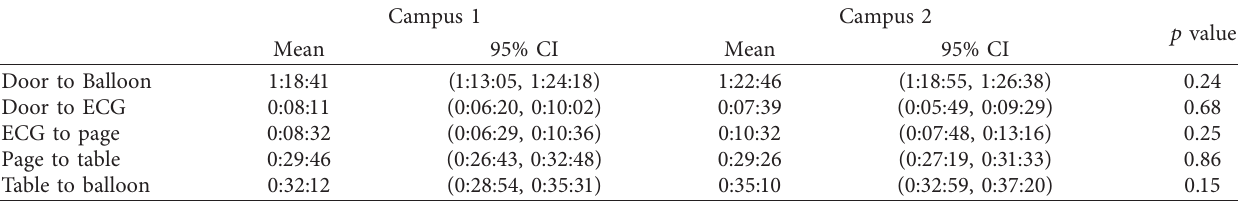
Figure 1: Comparison of door-to-balloon times between the overall population, Campus 1, and Campus 2. Error bars represent 95% confidence intervals. Table 4: Campus 1 ( n � 58) and Campus 2 ( n � 111) metrics for door-to-balloon times.